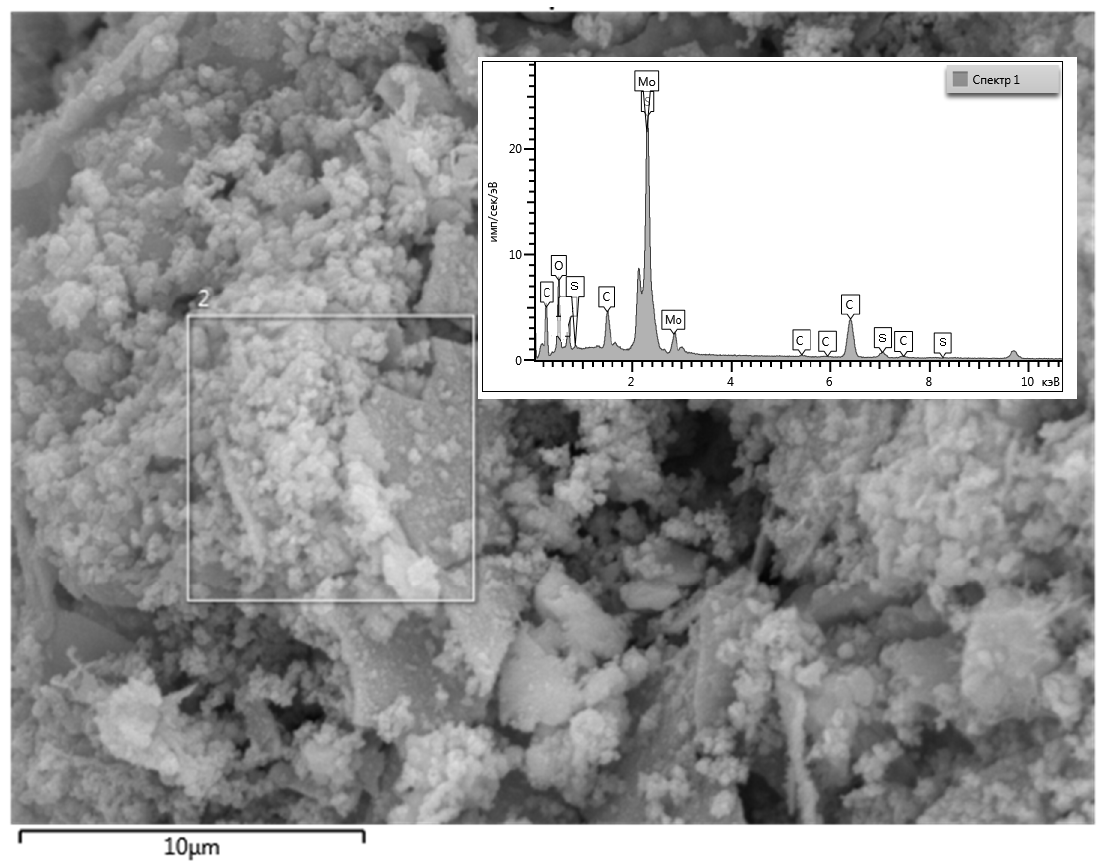
Figure 7. SEM-EDX image of the obtained particles from MoOHCs decomposition during heavy oil upgrading process.